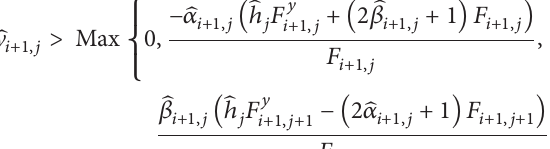
Figure 6: Bicubic Hermite surface.